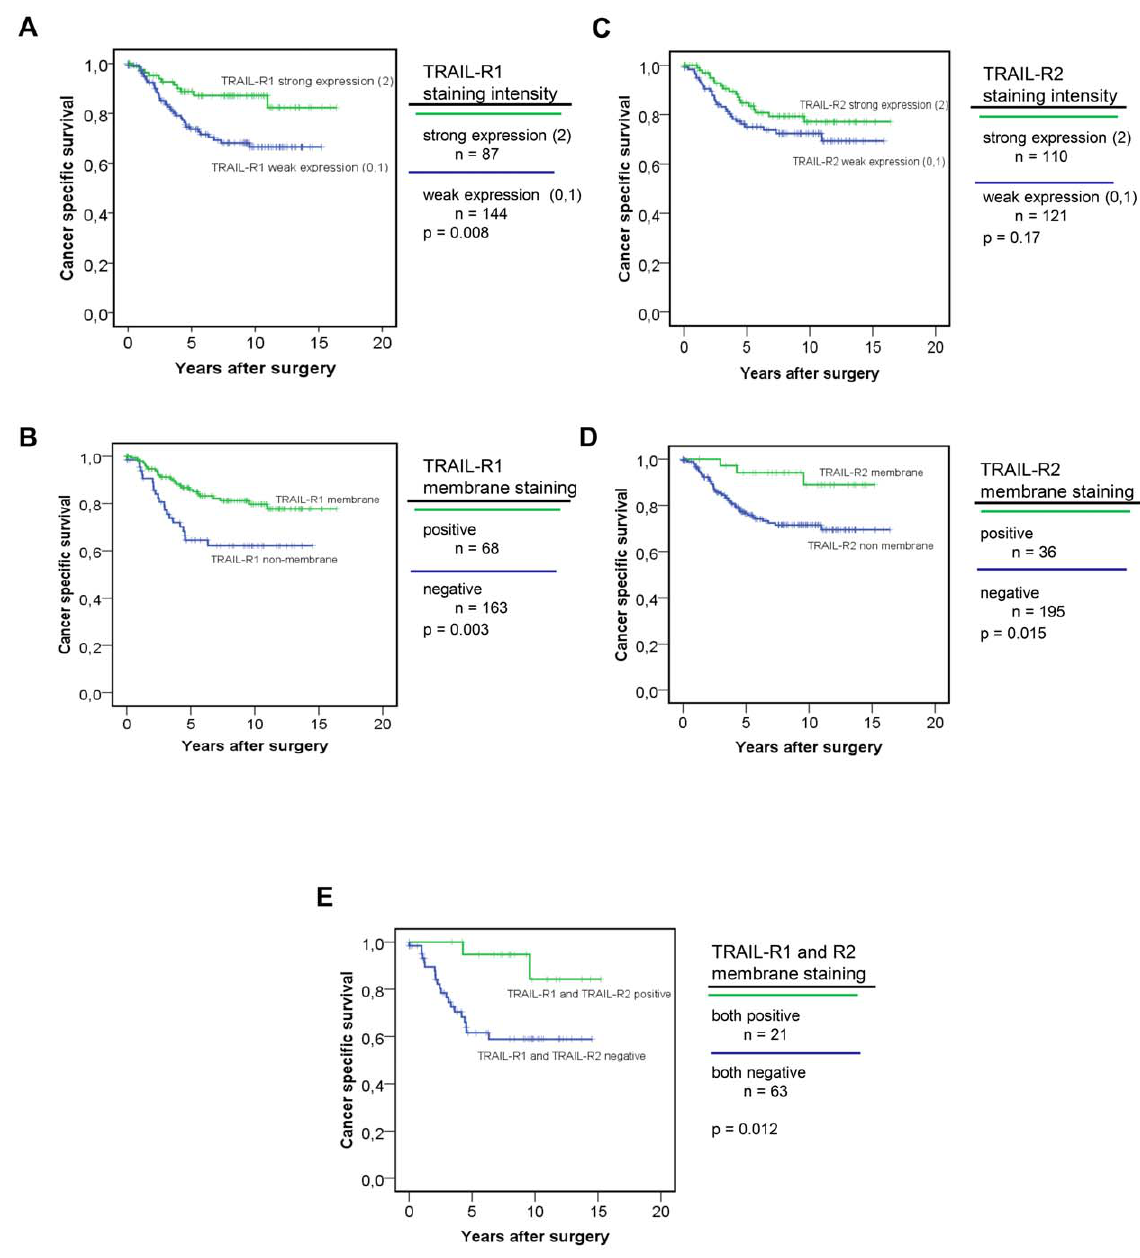
Figure 4. TRAIL-R1 staining and survival. ( A ) Survival plot of patients affected by colorectal cancer acc. to TRAIL-R1 staining intensity. In this and the following graphs censored cases are indicated by a cross. (B) survival curves of the same patients’ population categorized according to TRAIL-R1 staining on cell membrane. (C) Survival plot of patients according to the staining intensity for TRAIL-R2 (strong vs. weak expression). (D) survival plot of the same patient’s population categorized according to TRAIL-R2 cellular distribution. (E) Survival of patients according to membrane staining status of both TRAIL-receptors. Kaplan-Meier curves represent overall survival related to membrane staining of TRAIL receptor 1 and 2 vs. patients bearing tumors staining negative for both TRAIL